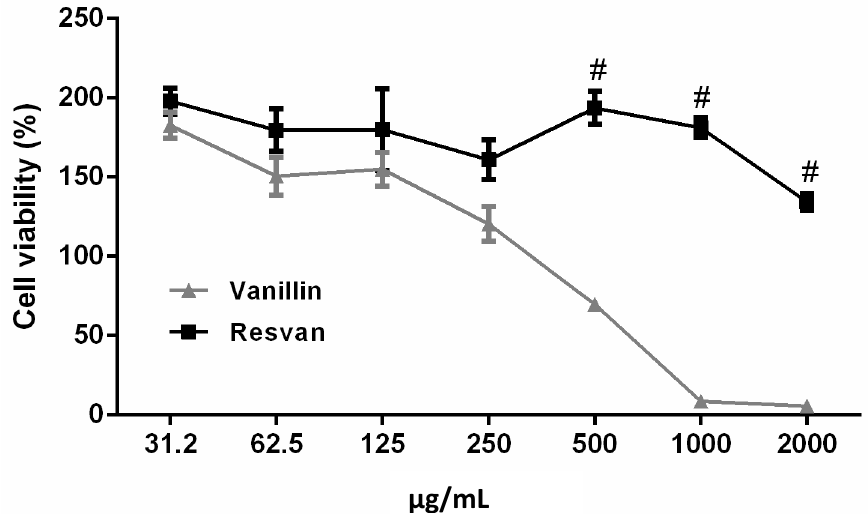
Figure 4. Influence of vanillin and resorcinarene in RAW 264.7 macrophage cell viability after treatment for 24 h. Results are expressed in percentage of control. Three independent experiments are performed in triplicate. ( # p < 0.001 compared to 500, 1,000 and 2,000 µg/mLvanillin